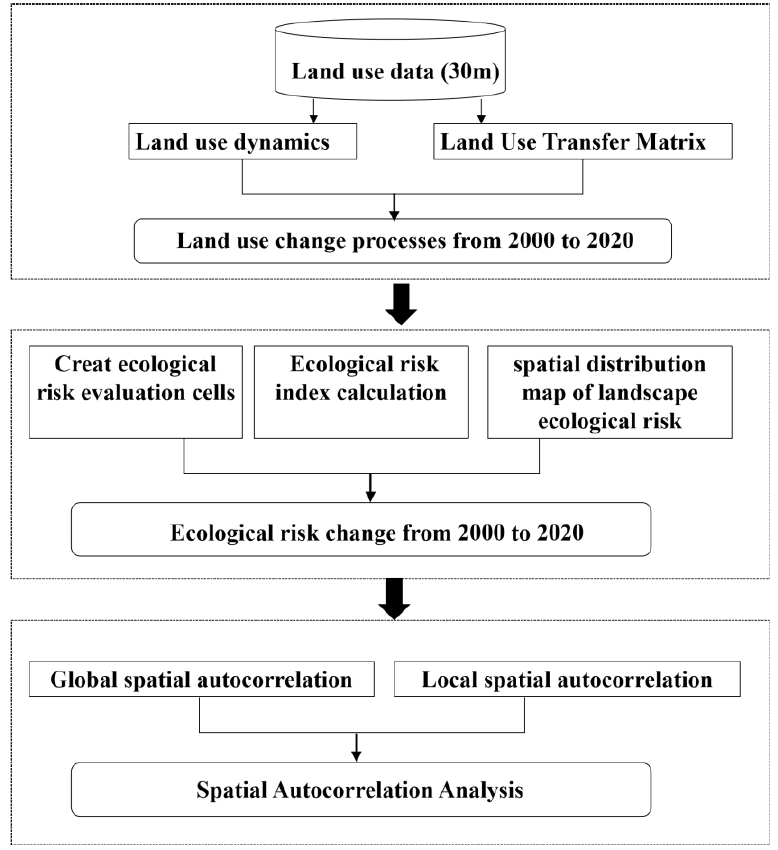
Figure 2. The workflow of the research .